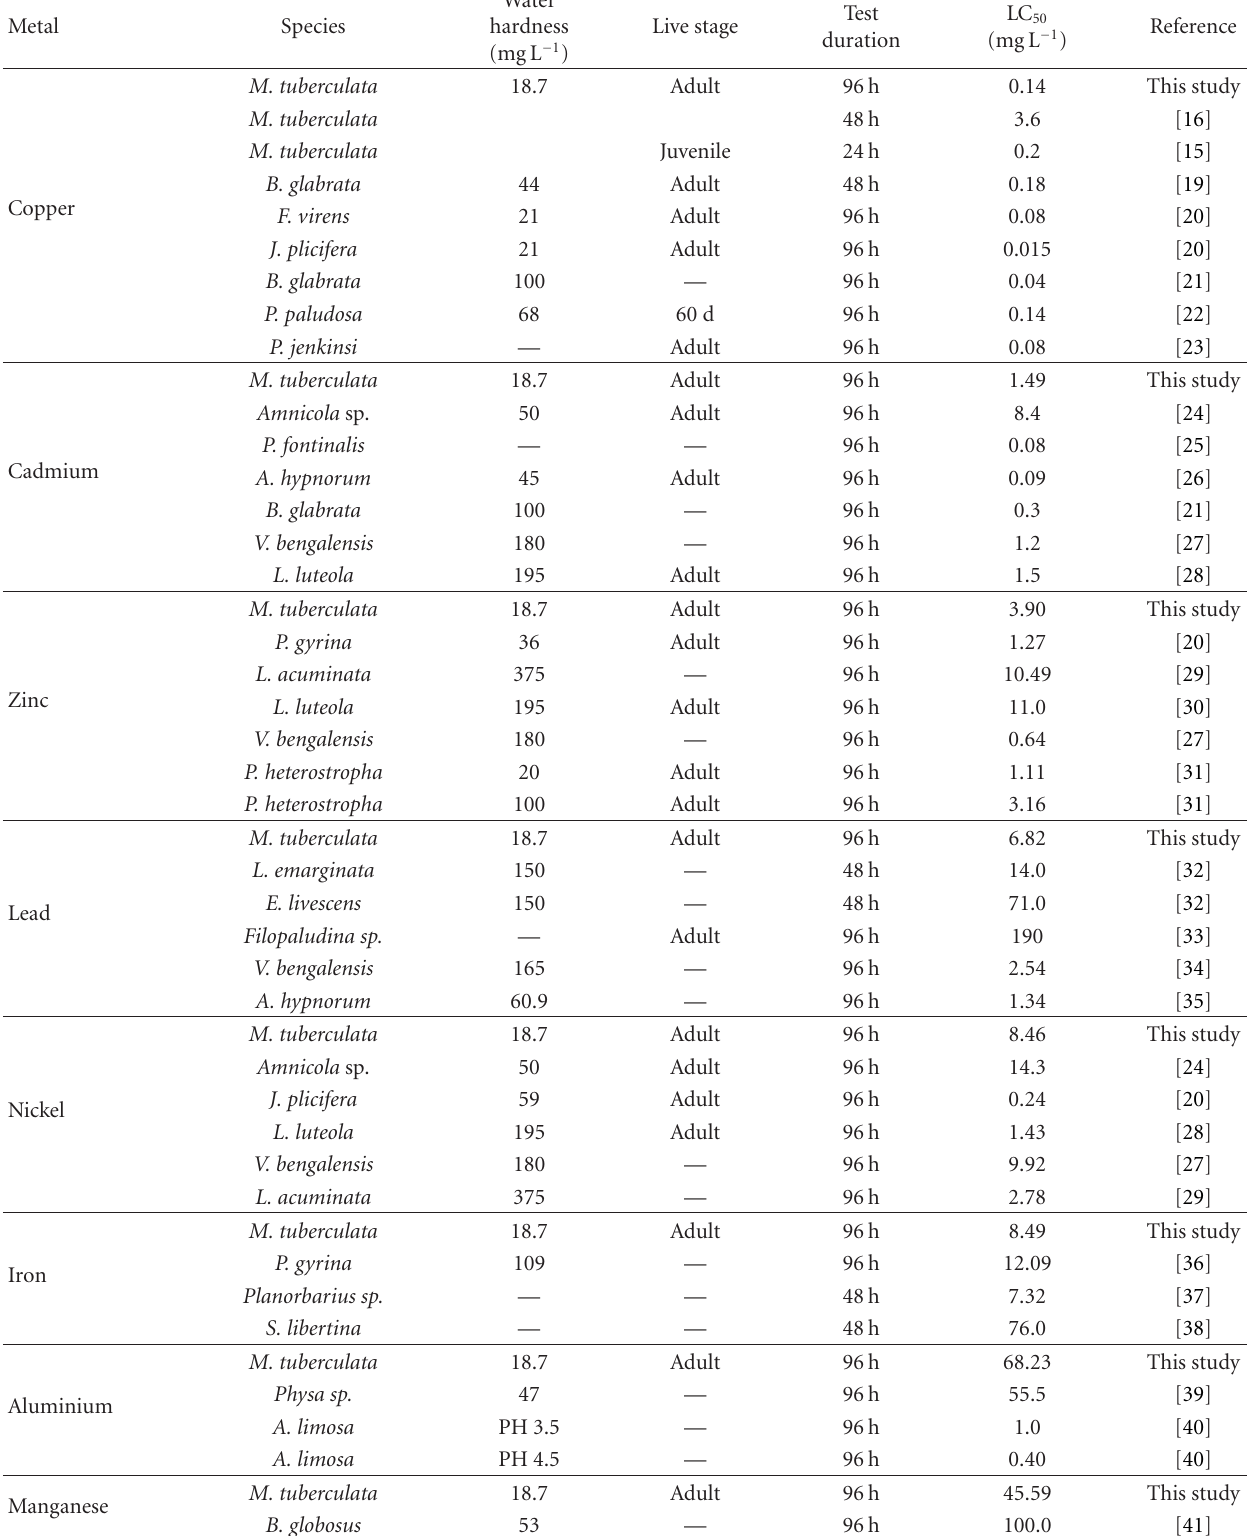
Table 3: Comparison of LC 50 values of freshwater gastropod M. tuberculata with other freshwater mollusc.